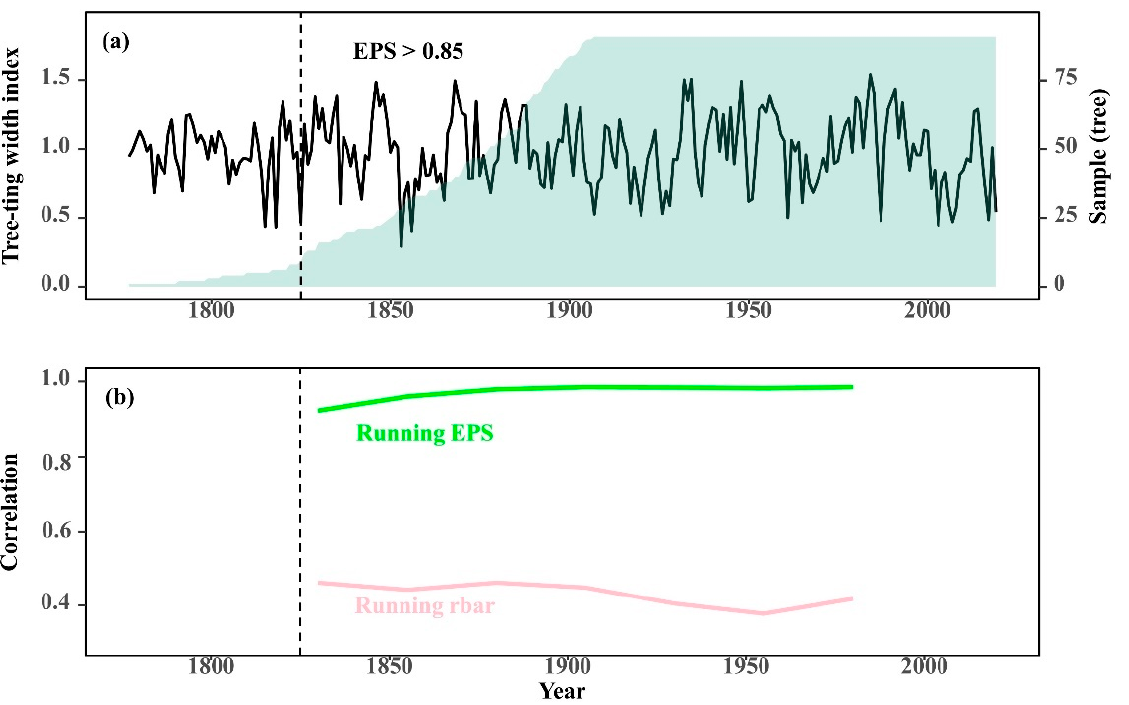
Figure 3. Regional tree-ring standard chronology (HLBE std ) and sample size ( a ); run Rbar (run based on a 50-year window with a lag of 25 years), run Expressed Population Signal (EPS) ( b ); EPS > 0.85 determines the chronology reliability period.